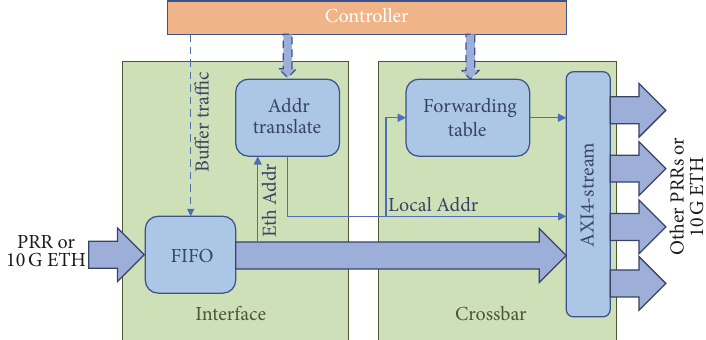
Figure 4: The detailed structure of the interface and dynamic crossbar of the